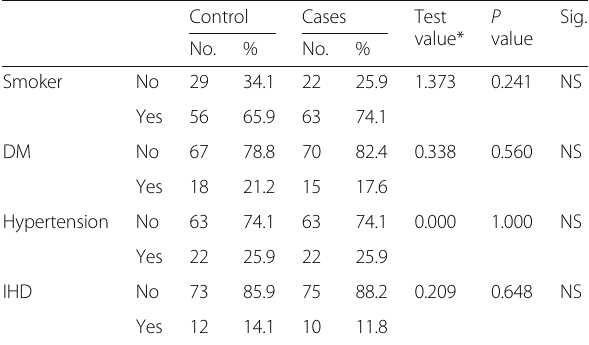
Table 2 Comparison between cases and controls regarding CAD risk